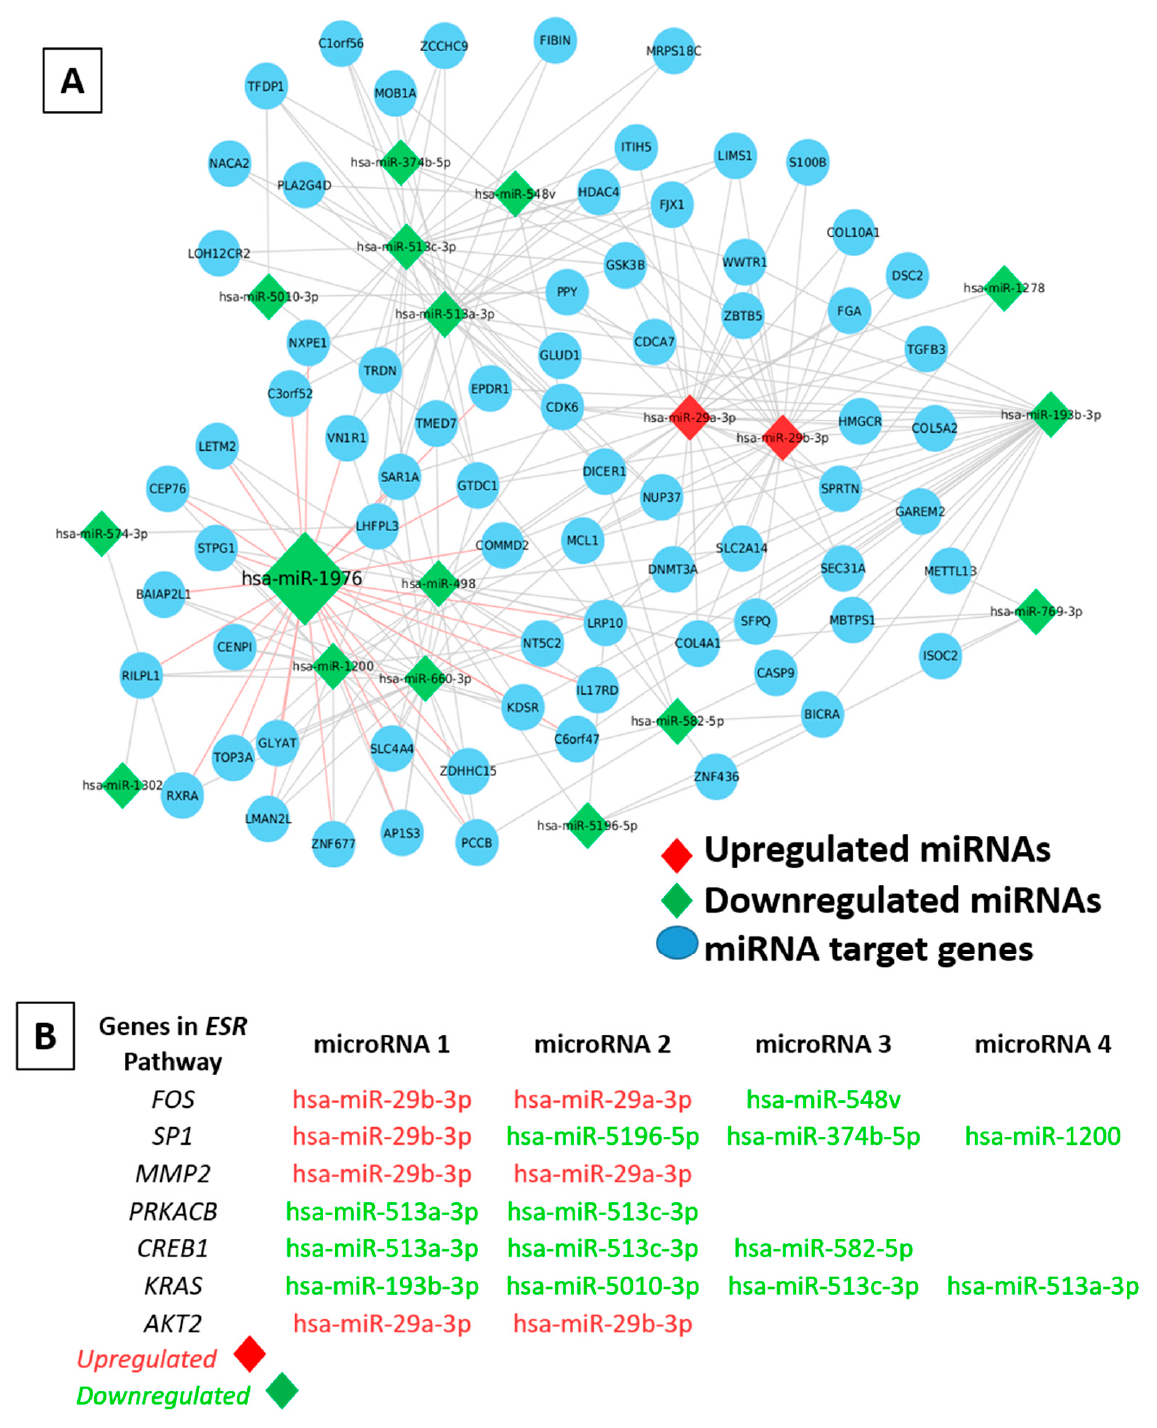
Figure 6. Differentially expressed miRNAs and mRNAs targeting the genes in the ESR pathway. ( A ) A network map of differentially expressed and statistically significant miRNAs across all ER −